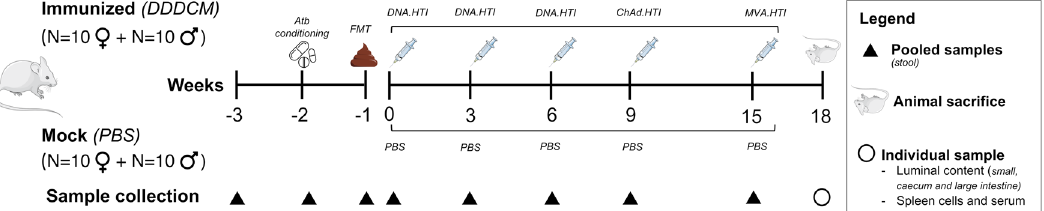
Fig. 1 Study design and sample collection. Female and male mice were immunized with an HIV T-cell vaccine (three DNA.HTI primes followed by a ChAd.HTI and MVA.HTI booster; n = 20) or a mock vaccine (PBS; n = 20). Antibiotic conditioning followed by fecal microbiota transfer was performed prior to vaccination to homogenize the intestinal content across all animals. Collection of samples, including stool, luminal content, serum and spleen was completed at the indicated time points. Abbreviations: FMT fecal microbiota transfer, Atb Antibiotic, PBS phosphate-buffered saline. The Figure was partly generated using Servier Medical Art, provided by Servier, licensed under a Creative Commons Attribution 3.0 unported